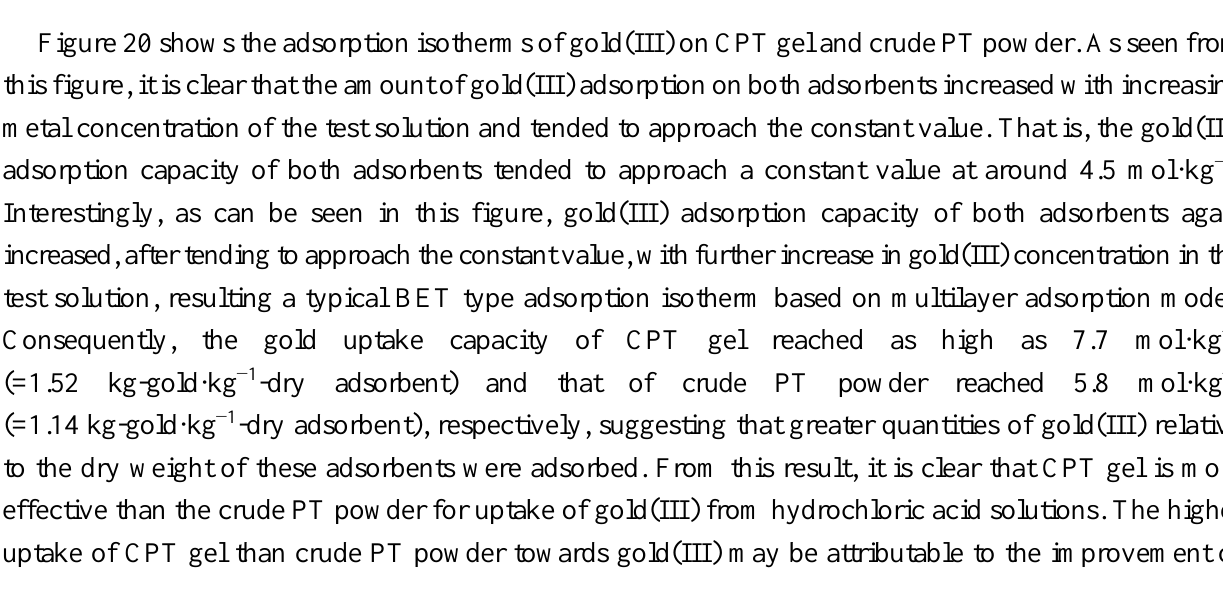
Figure 19. Percentage adsorption of various metal ions on crude PT powder as a function of concentration of hydrochloric acid [33] (with permission for reuse from Elsevier